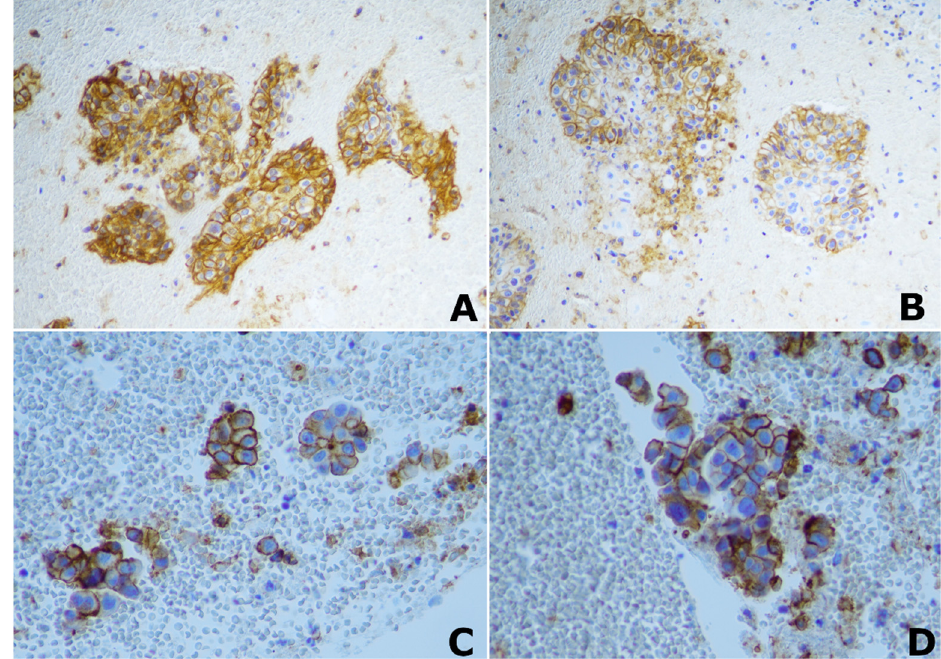
Figure 1. Immunohistochemical (IHC) staining of PD-L1. ×20 magnification image of positive PD- L1 IHC staining in two different patients with lung squamocellular carcinoma ( A , B ); ×40 magnification image of positive PD-L1 IHC staining in two different patients with lung image of positive PD-L1 IHC staining in two different patients with lung adenocarcinoma ( C , D adenocarcinoma ( C , D ).